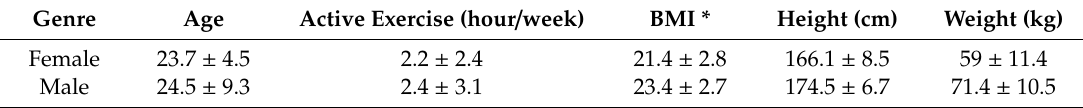
Table 1. Main characteristics of the subjects who participated in the